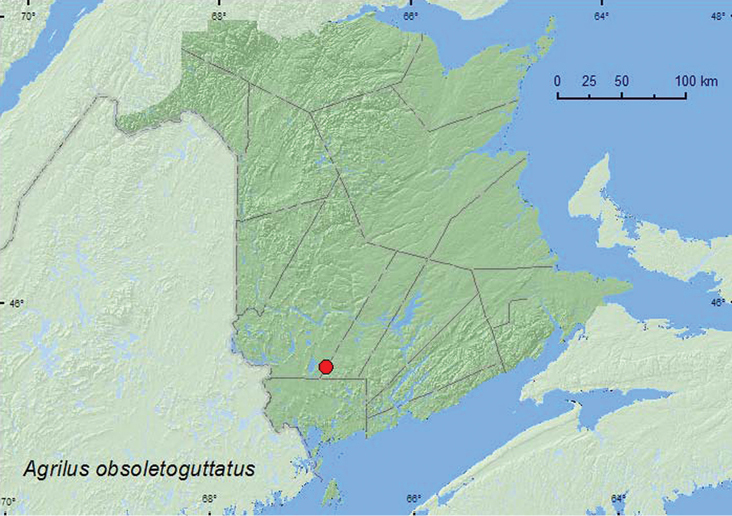
Collection localities in New Brunswick, Canada of Agrilus obsoletoguttatus.